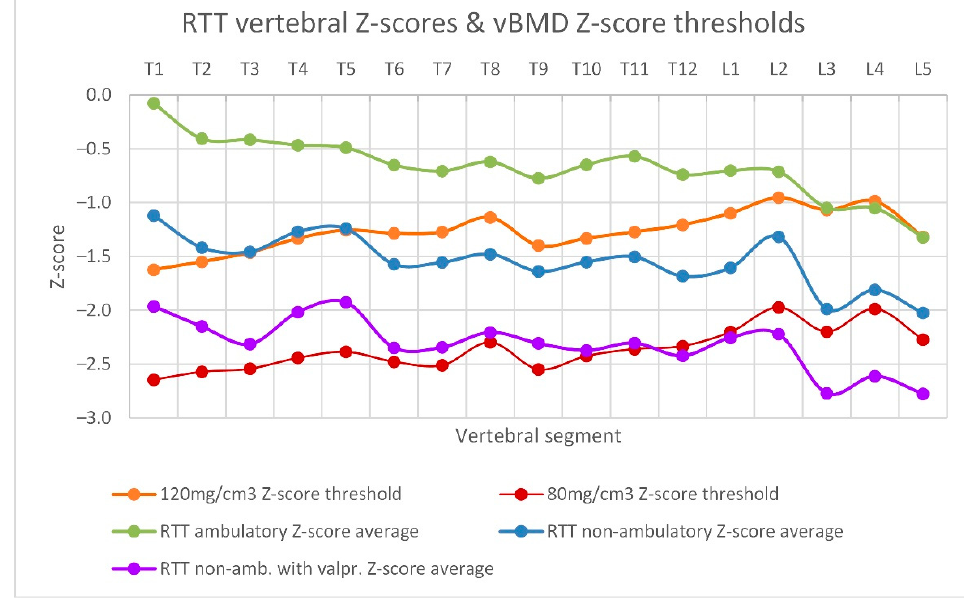
Figure 6. The Z-scores represent a higher fracture risk the lower they are in comparison to 120 mg/cm 3 vBMD Z-score threshold (orange) and 80 mg/cm 3 threshold (red). Z-scores of the ambulatory RTT subgroup remain in the normal range (n = 12, green), while those of non-ambulatory RTT girls (n = 9, blue) lie mostly below the 120 mg/cm 3 threshold. The purple line represents the non-ambulatory RTT subgroup with valproate treatment (n = 8). Depiction of the ambulatory RTT subgroup with valproate treatment (n = 3) is omitted as it overlaps considerably with the ambulatory subgroup.